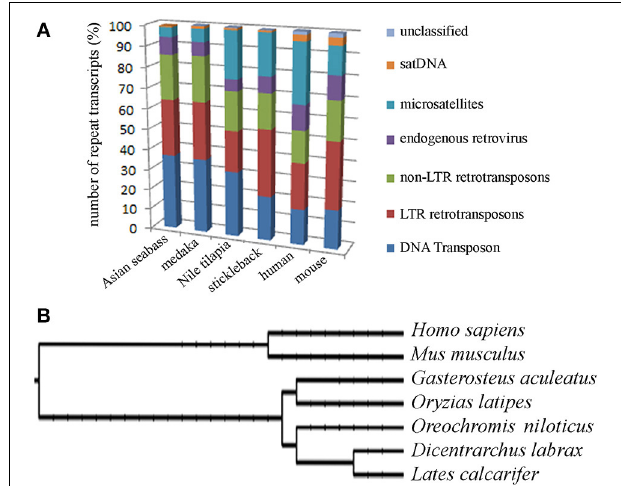
FIGURE 3 | Teleost and mammalian transcriptomes show similarity to the non-coding regions of genomes as they also contain various amounts of different dispersed and tandem elements. (A) Comparative analysis of the relative proportion of repeat types in the transcriptome of four teleosts and two mammals. The repeat content of the Asian seabass transcriptome is closer to that of the Japanese medaka than those of the Nile tilapia and the three-spined stickleback. On the Y axis, the percentage of repeat transcript sequences with Repbase hits from all the transcripts are shown. (B) Phylogenetic relations between human ( Homo sapiens ), mouse ( Mus musculus ), three-spined stickleback ( Gasterosteus aculeatus ), medaka ( Oryzias latipes ), Nile tilapia ( Oreochromis niloticus ), European seabass ( Dicentrarchus labrax ), Asian seabass ( Lates calcarifer ) were generated by Tree of Life interactive tool (Letunic and Bork, 2011).